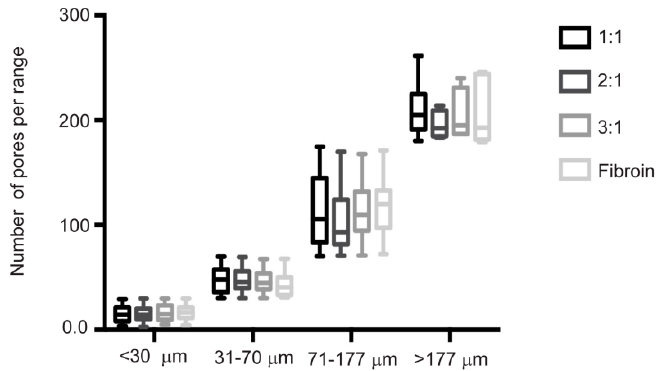
Figure 3. Box-whisker plots showing the pore size distribution for the cartilage phase of the biphasic implant. The graph displays the porosymmetric analysis of the scaffold, expressed as the relative abundance of each pore size in a representative volume. The data are reported as the mean ± SD.